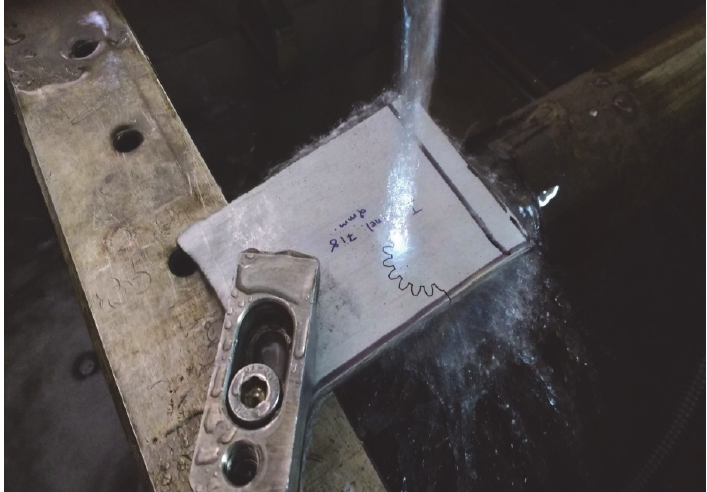
Fig. 1. Machining of the work-piece material by Wire